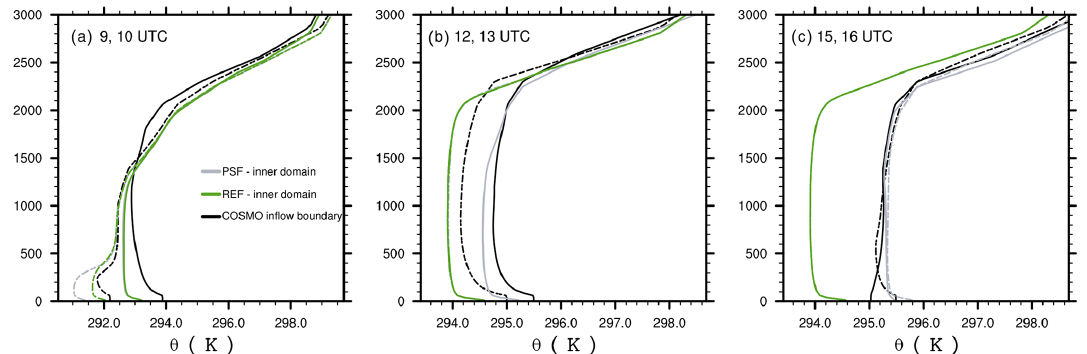
Figure 9. Vertical profiles of potential temperature prescribed at the inflow boundary as well as within the inner part of the domain where the flow has been spatially fully developed. Profiles are shown for simulation REF (green) as well as for a test simulation PSF (grey) with prescribed surface heat fluxes obtain from COSMO. Profiles are shown for (a) 09:00 and 10:00UTC, (b) 12:00 and 13:00UTC, and (c) 15:00 and 16:00UTC as dashed and solid lines,